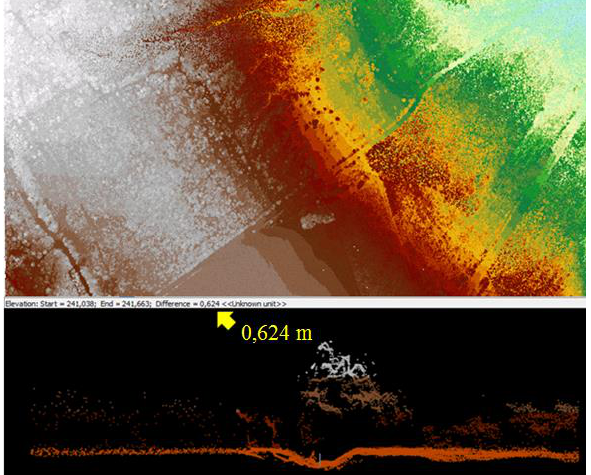
Figure 8. The original point cloud (top) and a typical profile (down) in Bükk National Park area